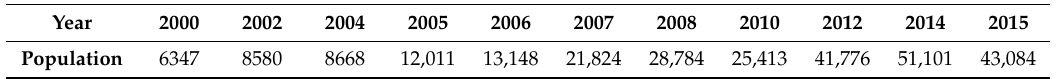
Table 1. Regional Municipality of Wood Bu ff alo Shadow Population. Source: Regional Municipality of Wood Bu ff alo Census 2015